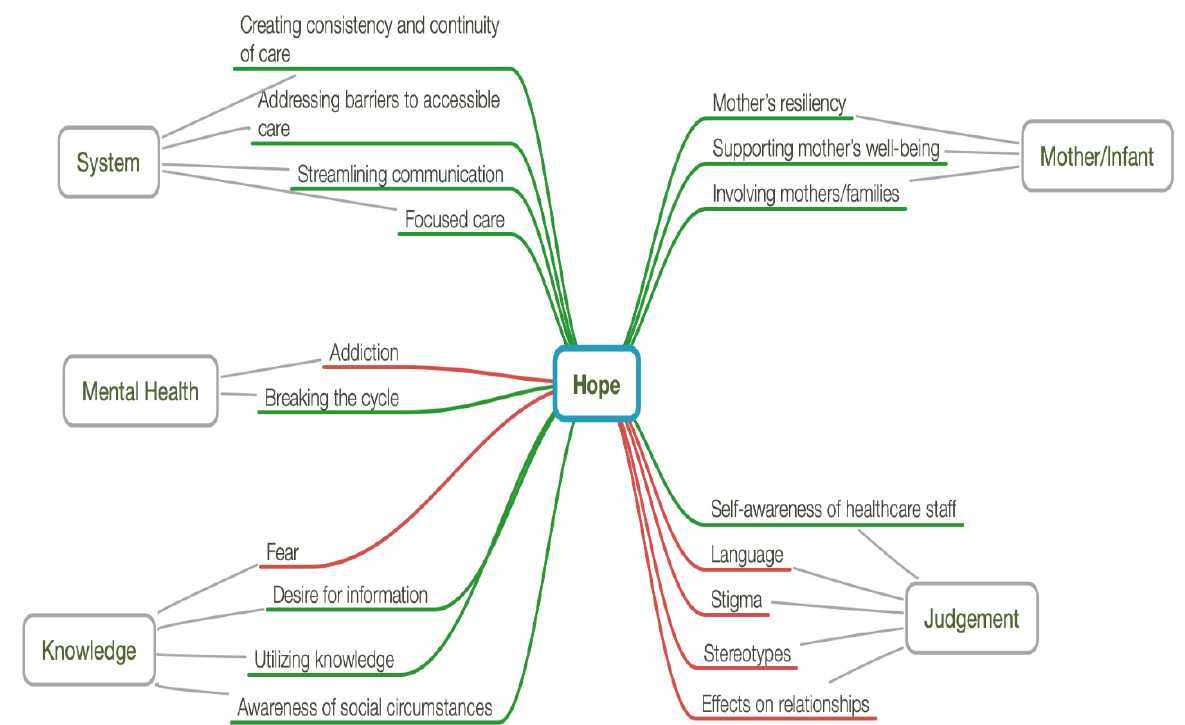
Figure 1. MindNode map identifying themes associated with the dynamics of caring for infants at risk for NAS and their families. The red lines represent barriers to hope within each primary theme. The green lines represent facilitators of hope within each primary theme.